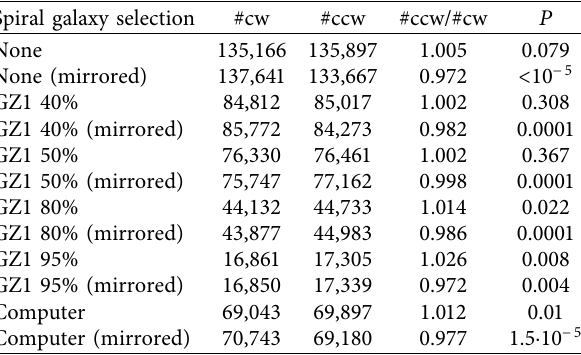
Table 1: Te distribution of galaxies spinning clockwise and counterclockwise in the entire dataset. Te P values are the one-tailed binomial distribution probabilities when assuming a 0.5 probability of a galaxy to spin clockwise or